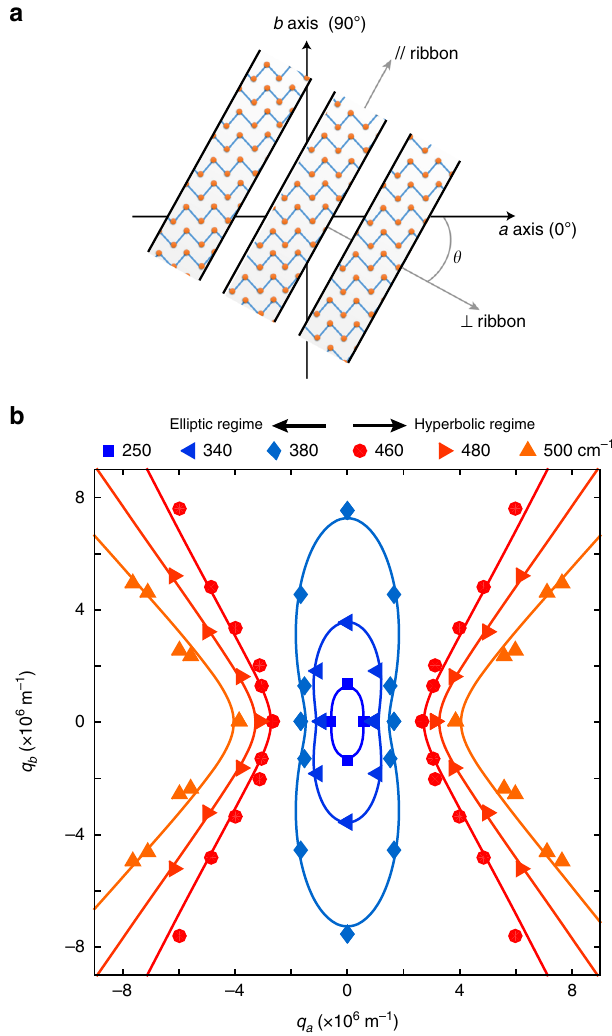
Fig. 5 Isofrequency contours for the topological transition. a The schematic of a skew ribbon array. Zigzag features are plotted inside the ribbons to represent the tungsten chains along the a axis. b Isofrequency contours of the plasmon at different frequencies. Data points in the fi rst quadrant are measured in rectangle/ribbon arrays of WTe 2 fi lms with fi lm thickness of 100 ± 20 nm on polycrystal diamond substrates with plasmon resonance frequencies at 250 ± 10 , 340 ± 10 , 380 ± 10 , 460 ± 8 , 480 ± 8 , and 500 ± 5 cm – 1 , respectively. Points in other quadrants are duplicated according to the crystal symmetry. The solid lines are plotted based on the optical conductivity (see